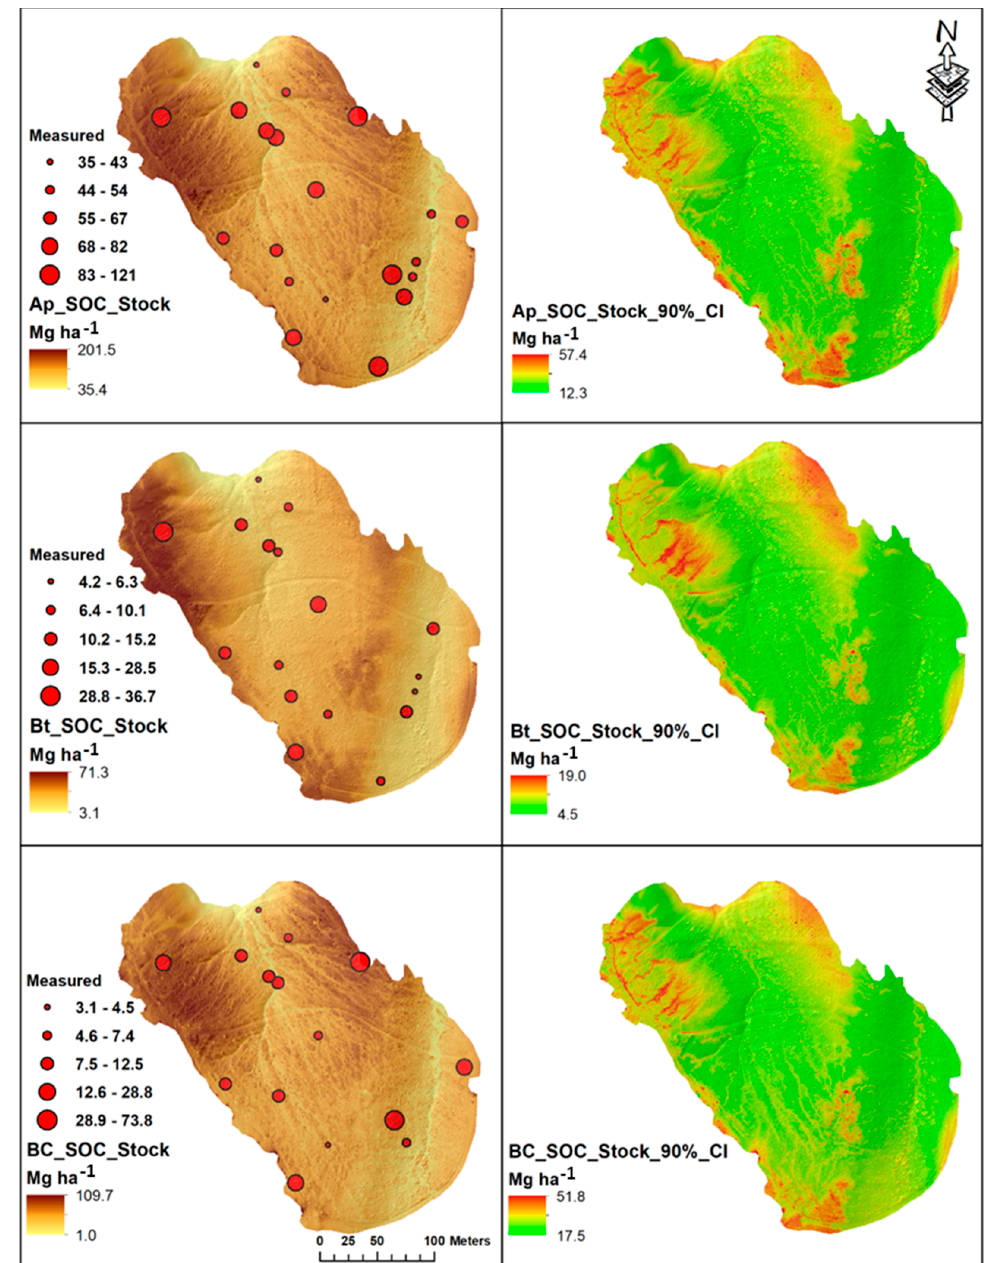
Figure 6. Spatial distribution of measured versus predicted SOC stocks (90% confidence interval, CI) for soil horizons on the prairie grass site.